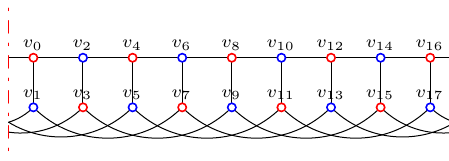
Figure 15. Segments of f in Case 3 in Lemma 8.